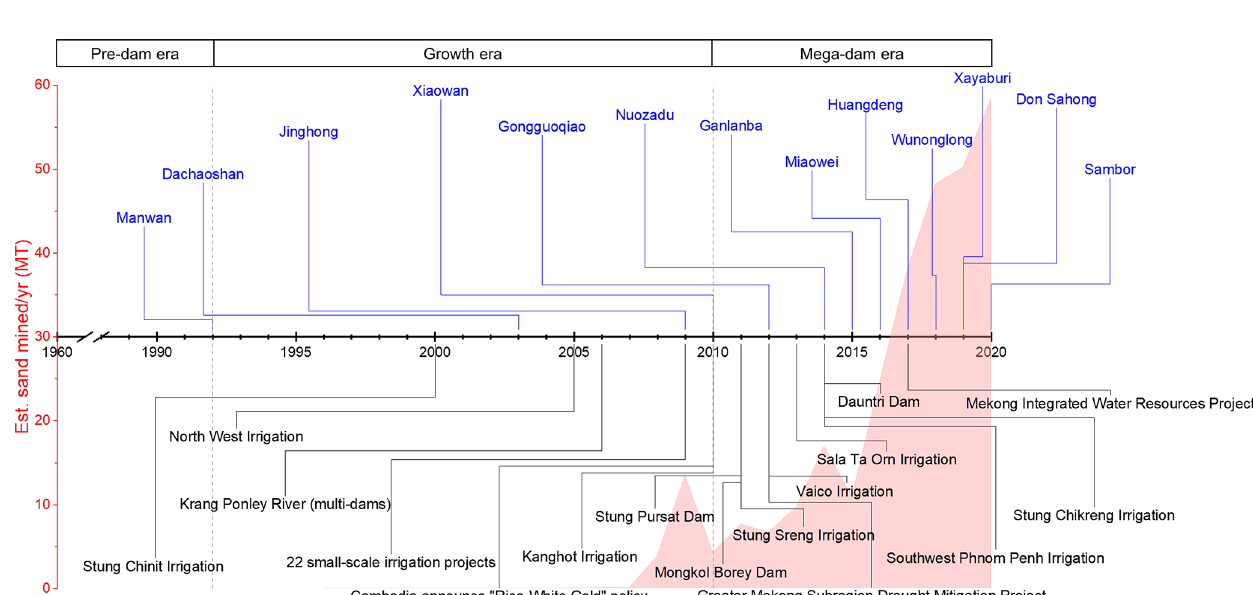
Figure 2. Timeline of major water infrastructure activities in the Cambodian floodplains and the wider Mekong Basin. Blue labels indicate mainstream dams constructed across the Mekong (including the Lancang Cascade). Black labels indicate irrigation projects within Cambodia. The red chart represent the estimated rate sand mined per year in millions of tonnes (Mt). Mining data from 1998–2015 were obtained from the United Nations (2017), while mining data from 2016–2020 were obtained from Hackney et al.